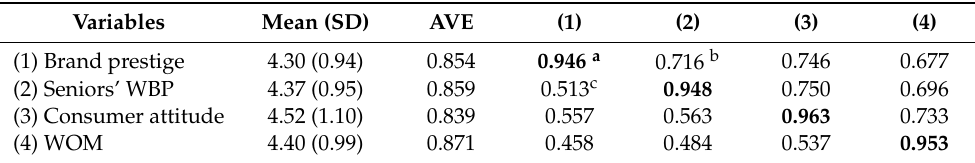
Table 3. Descriptive statistics and associated